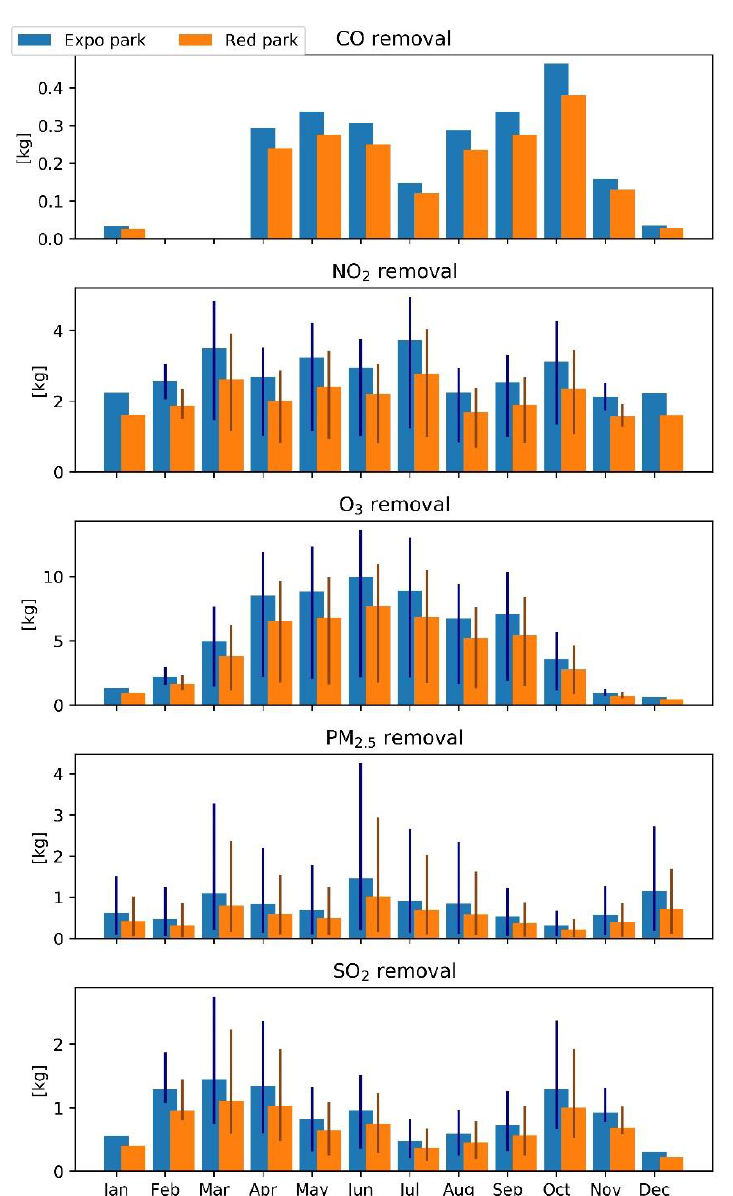
Figure 5. Monthly pollution removal of CO, NO 2 , O 3 , PM 2.5 , and SO 2 from EXPO and RED Park of Tbilisi in 2018. The range indicated by the bar for all pollutants (except CO) shows the removal calculated by the model using a minimum and maximum deposition velocity.